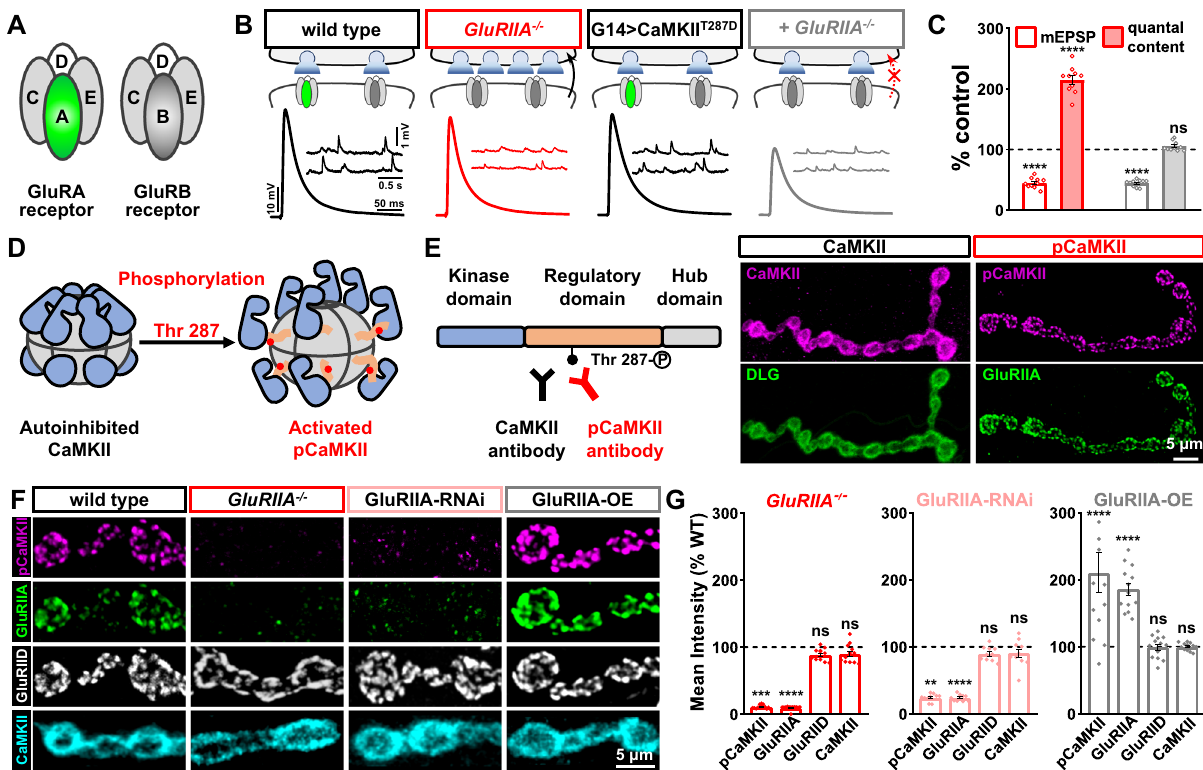
Fig. 1 | Active CaMKII localizes to postsynaptic glutamate receptor fi elds and correlates with GluRIIA expression. A Schematic depicting the subunit compo- sition of GluRA and GluRB glutamate receptor subtypes at the Drosophila NMJ. B Schematic and representative traces illustrate that postsynaptic expression of constitutively active CaMKII blocks the chronic expression of presynaptic homeo- static potentiation (PHP) that is normally induced by loss of the GluRIIA subunit.